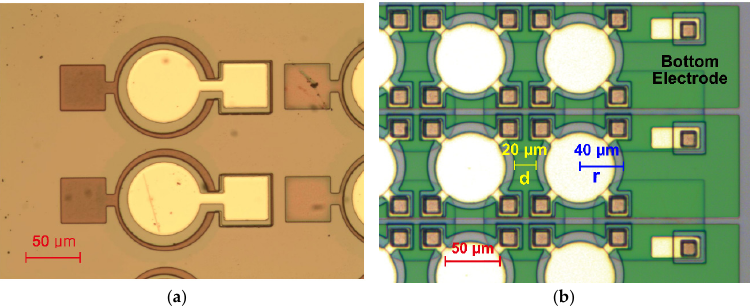
Figure 4. Fabricated ( a ) single-element and ( b ) 20 × 20 array of AlN pMUTs.